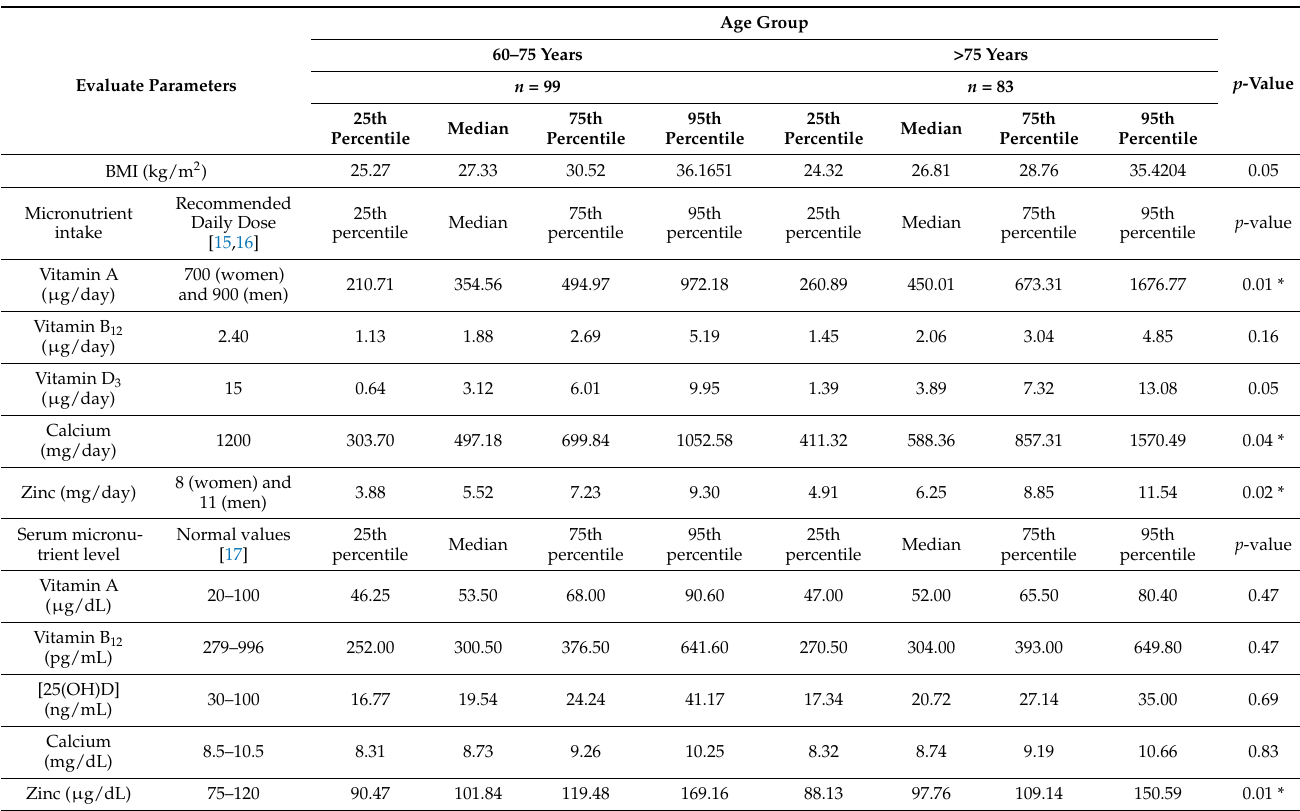
Table 3. Influence of the age group on the BMI, micronutrient intake and serum micronutrient levels of elderly from Metropolitan Region, Santiago,